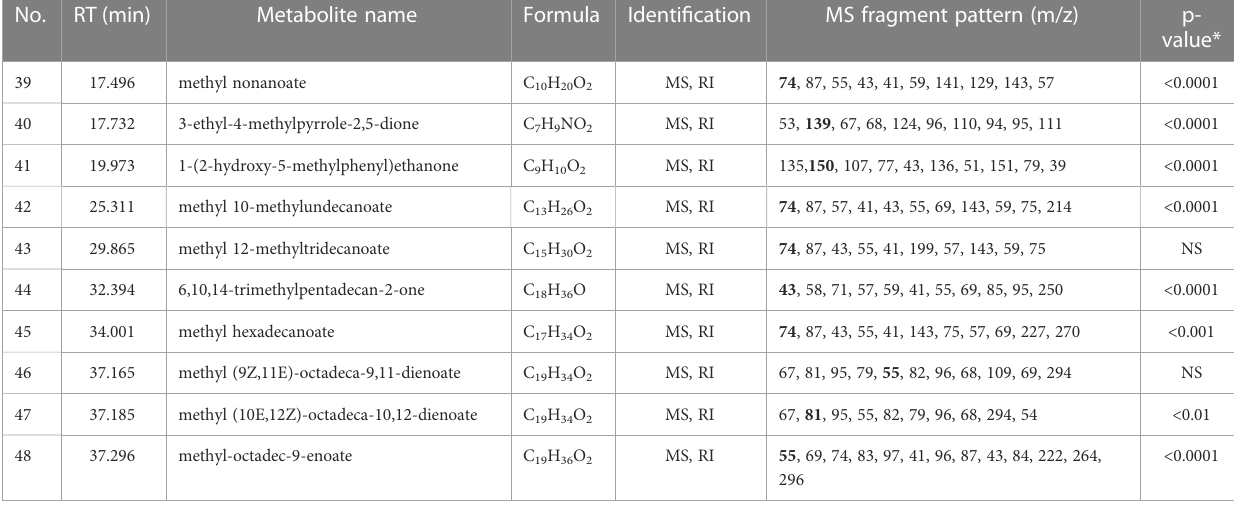
Table 2. 2-methoxyphenol levels in both aromatic and non- aromatic black rice were signi fi cantly higher than in white and red rice (p<0.0001), with the highest f-value (393.94) and the highest VIP score (>2.0). This fi nding agrees with previous